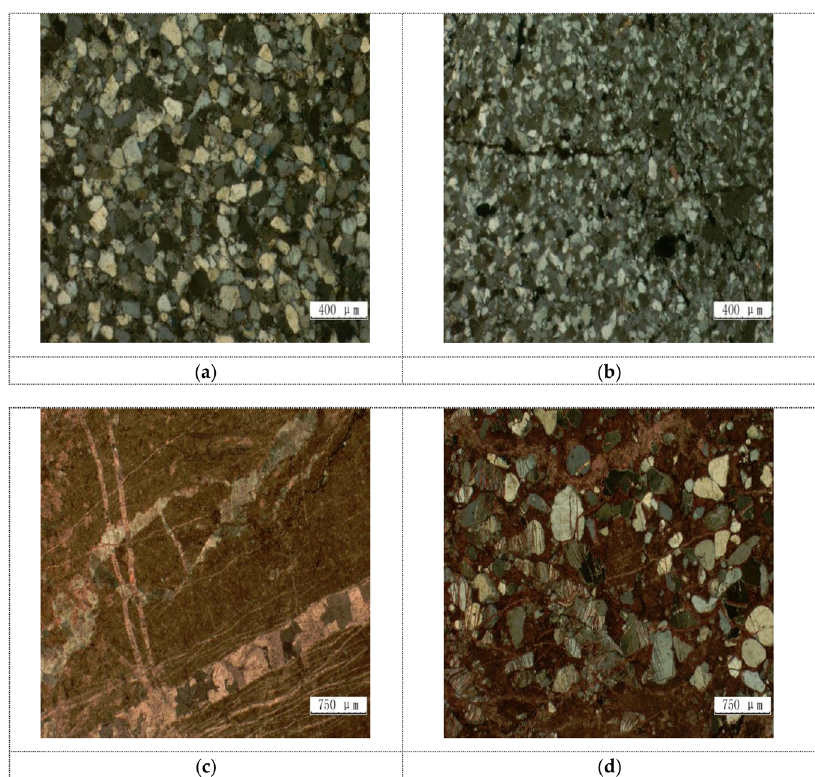
Figure 6: Compaction observed by microscopic thin sections of samples under re fl ected light. ( a ) Orthogonal light ( X5 ) , authigenic clay is mainly composed of quartz grains wrapped in thin fi lms; ( b ) orthogonal light ( X5 ) , rock is compacted and the particles are mostly concave – convex – linear contact. It can be seen that many sutures are fully fi lled with iron oxide, carbon, and mud. A small amount of carbon fi lled between grains; ( c ) orthogonal light ( X2.5 ) , wrist foot and debris are seen in thin sections, mostly heavy crystallization, with unclear structure. Dolomite is the product of metasomatic calcite, mostly fi ne crystal structure; several dissolution and structural fractures are visible, mostly fi lled by calcite and dolomite; ( d ) orthogonal light ( X2.5 ) , the debris is mainly quartz, and local micro - cracks are very developed and fi lled with calcite. Several structures and dissolution fractures are completely fi lled by